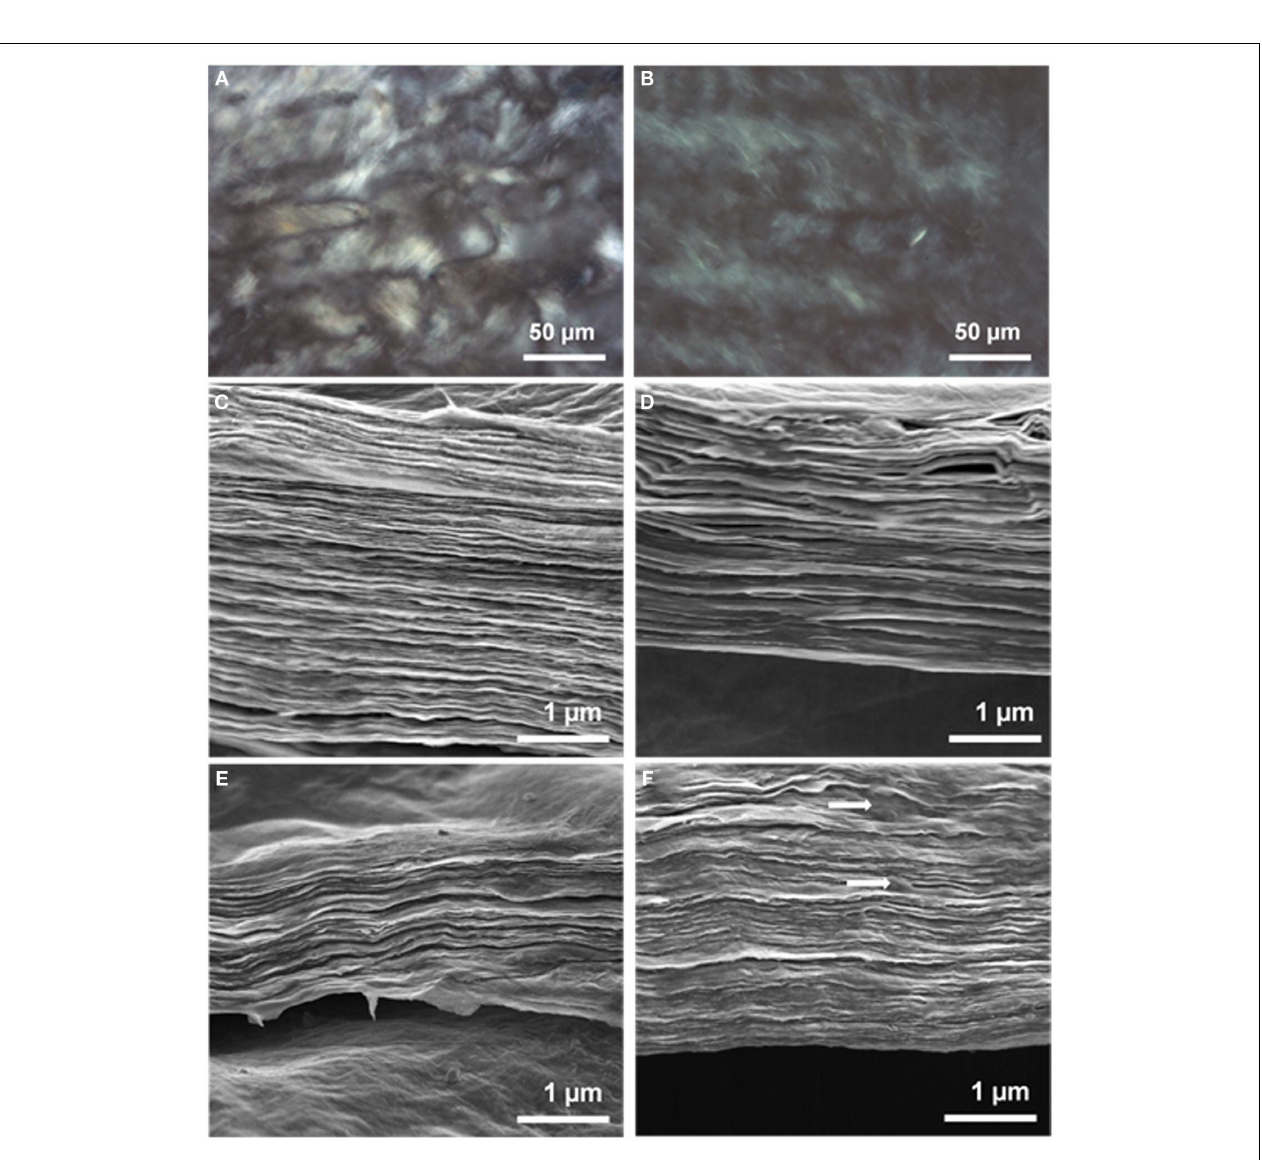
FIGURE 2 | Representative polarized optical microscope images of (A) LC GO and (B) GO-PP 25 at a concentration of 2.5mgmL − 1 . FE-SEM micrographs of dried composites: (C) GO, (D) GO-PP 25, (E) GO-PP 50, and (F) GO-PP 75, with the arrows marking the PEDOT:PSS overlap